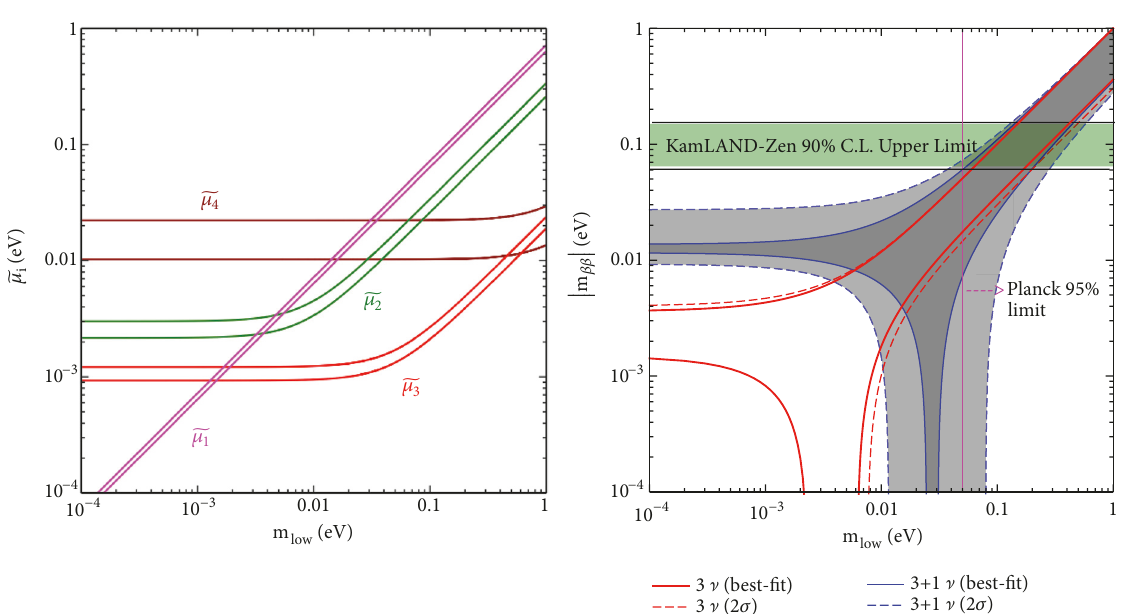
Figure 1: Left panel shows the four partial mass contribution to |𝑚 𝛽𝛽 | in (12) as function of the lightest mass 𝑚 𝑙𝑜𝑤 for 3𝜎 allowed intervals in the case of 3+1 ] mixing with Normal Ordering. Right panel shows the allowed ranges in the |𝑚 𝛽𝛽 | - 𝑚 𝑙𝑜𝑤 parameter space, both in the standard three-neutrino picture (unfilled band space) and with one sterile neutrino (filled band space) for the 3+1 case as defined by (14).